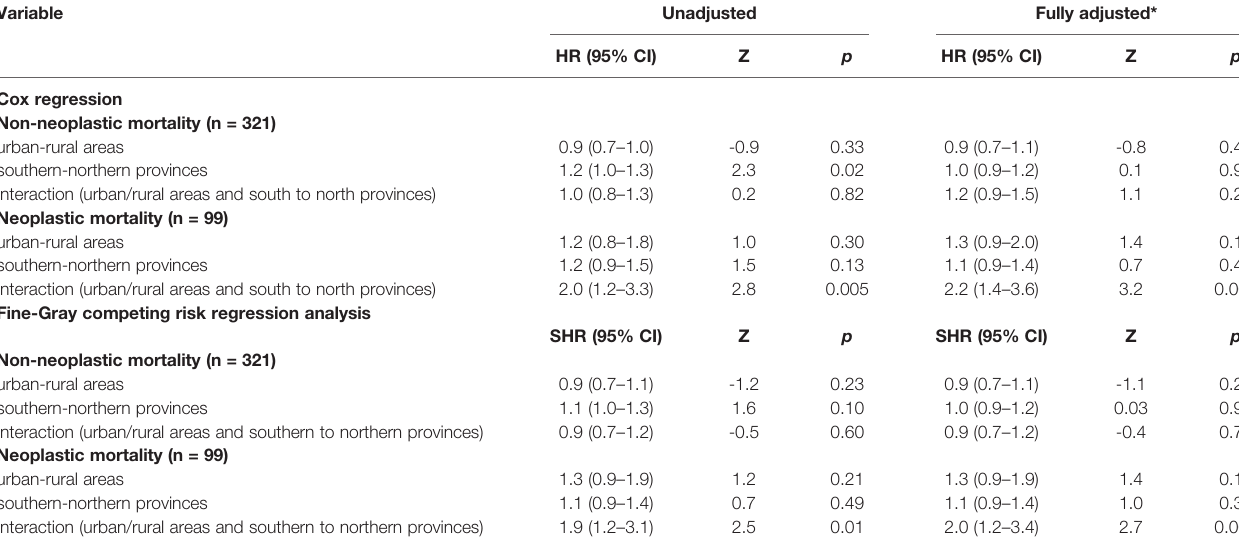
TABLE 3 | Cox regression and Fine-Gray competing risk regression analysis of non-neoplastic and neoplastic mortality risk over 22 years of follow-up after ACS with the interaction for risks between the six geographic areas after excluding patients who had malignancy and were still alive (n = 519).